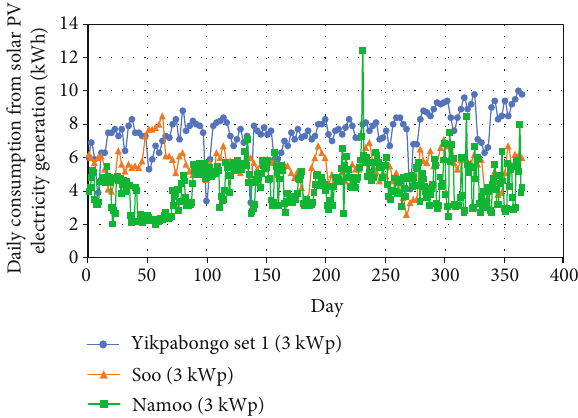
Figure 3: Daily in-house consumption from solar PV electricity